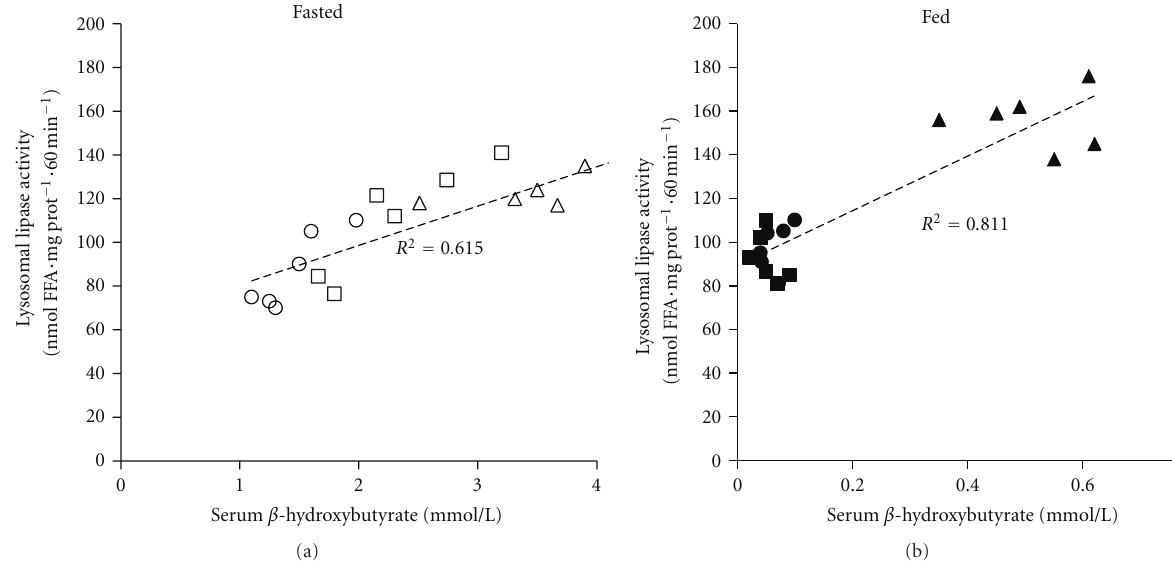
Figure 5: The correlation between lysosomal lipase activity and β -hydroxybutyrate content in serum. Lysosomal lipase activity was determined as the FFA release from endogenous TAG. Open circle = SD-fasted; open square = HS-fasted; open triangle = HF-fasted; closed circle = SD-fed; closed square = HS-fed; closed triangle =